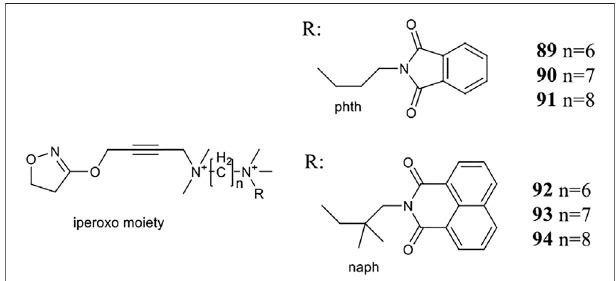
FIGURE 7 | Iperoxo derivatives investigated at the M 1 receptor in the study of Holze et al. (2020).